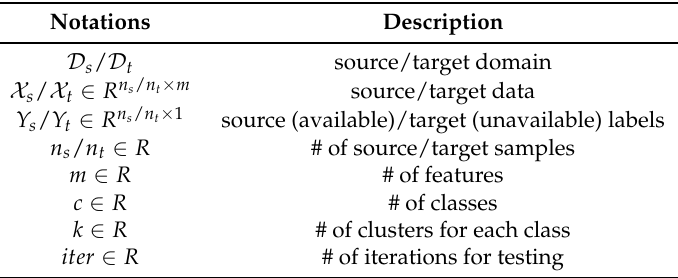
Table 1. Notations and descriptions used in this paper.